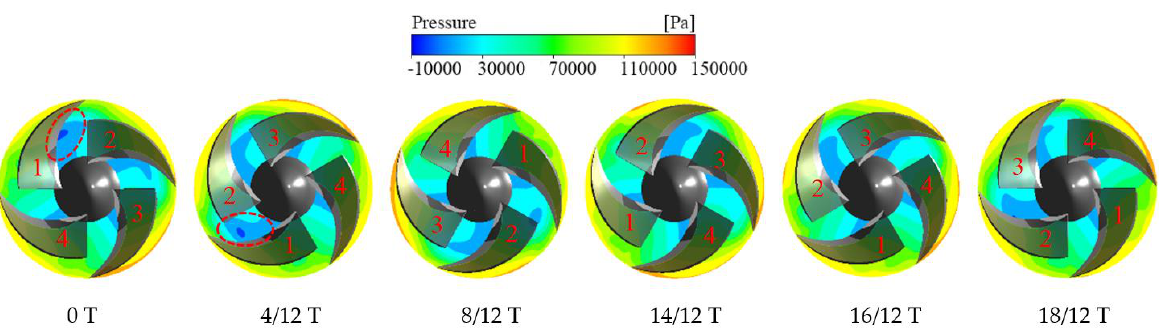
Figure 13. Pressure nephogram of impeller outlet section at different times ( δ = 0.5 mm).